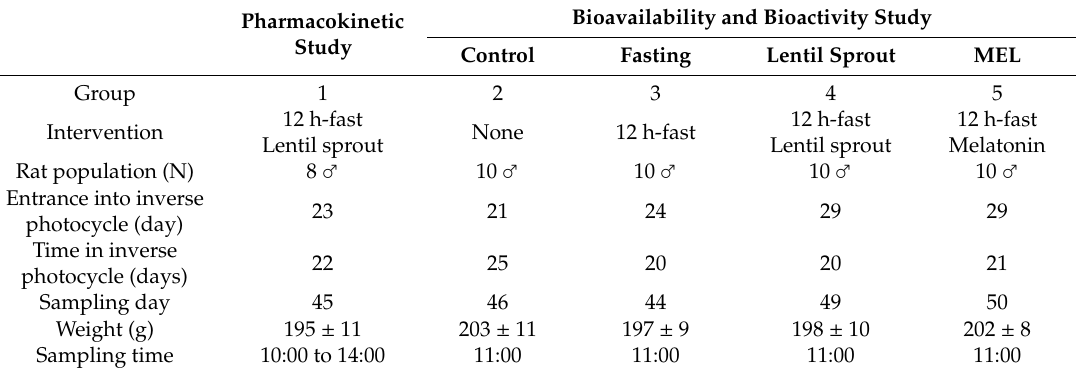
Table 1. Experimental conditions for the pharmacokinetic and bioavailability / bioactivity studies considering the intervention, rat population, date of entrance and time into inverse photoperiod, sampling day, mean group weight on the day of the experiment, and sampling